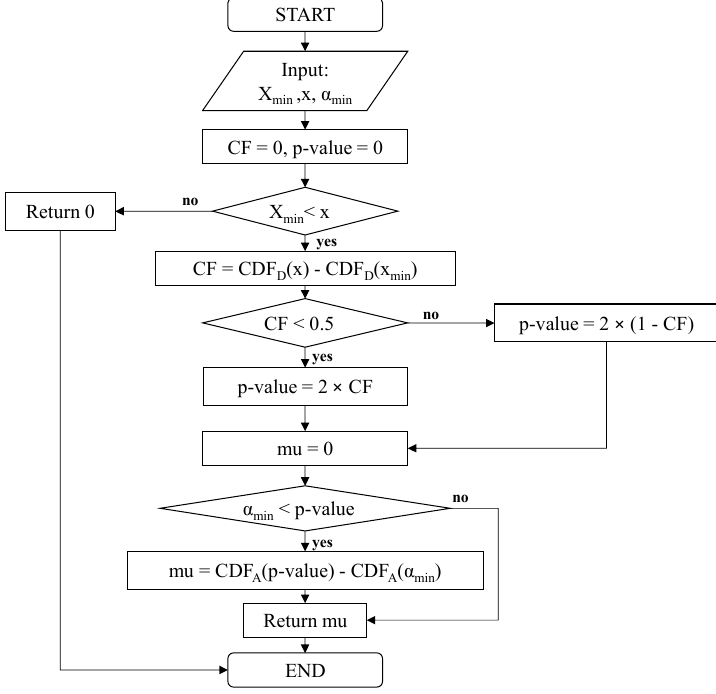
Fig. 3. Algorithm for probability-possibility